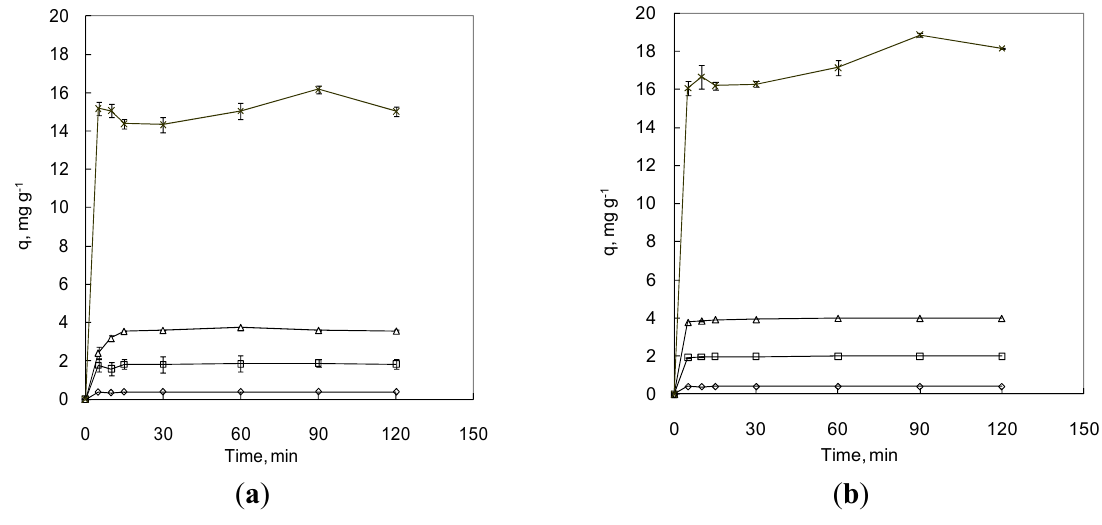
Figure 3. Adsorption of As(III) ( a ) and As(V) ( b ) by MNP under anaerobic condition. Rhombus, square, triangle, and cross represent initial concentrations of 10, 50, 100, and 500 μ g·L − 1 , respectively. Error bars indicate CI 95%.